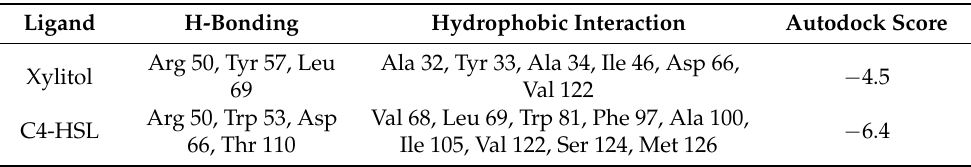
Table 1. The binding mode of xylitol and natural ligand with the different residues inside the active site of SmaR